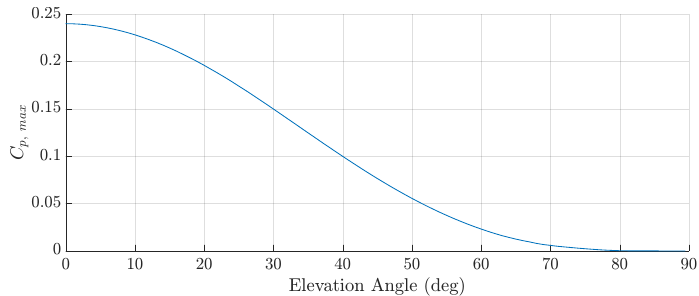
Figure 23. Variation in C pmax with system elevation angle.